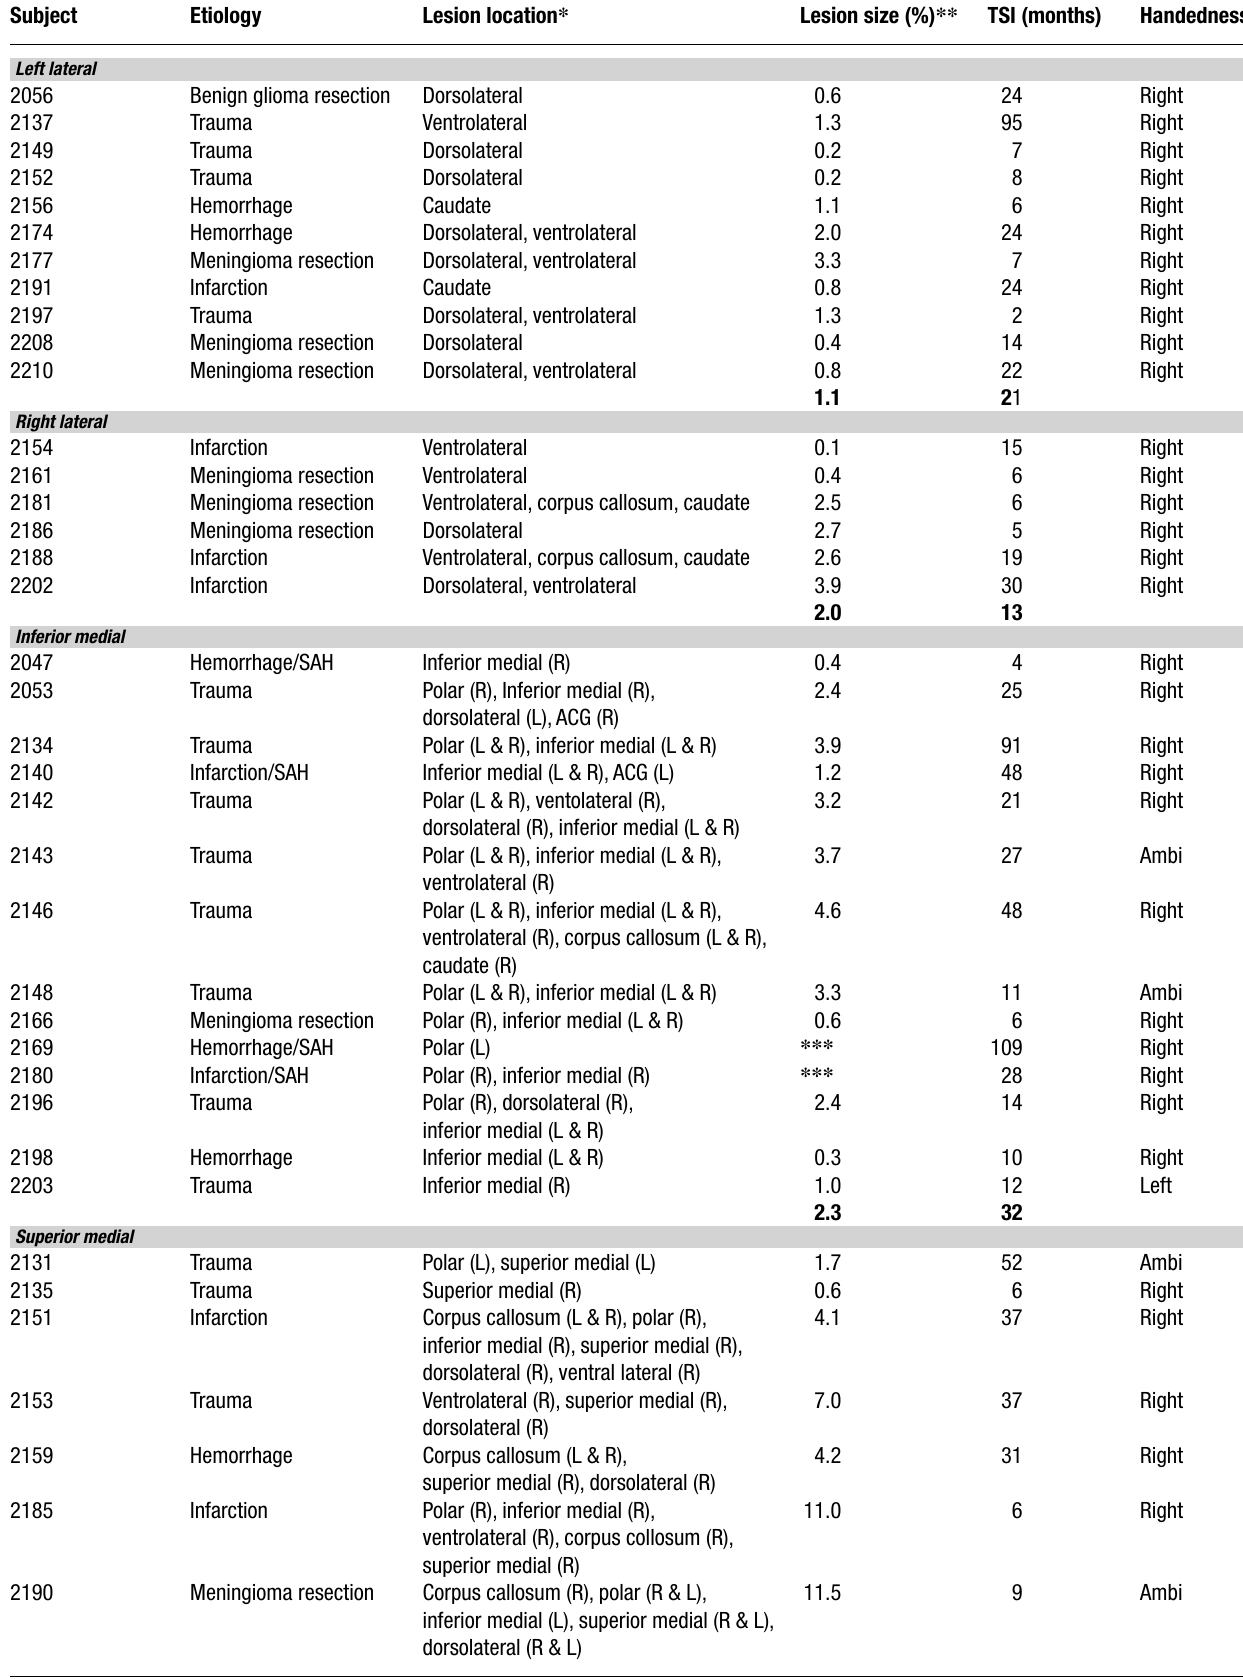
Table 1. Etiology, lesion location, lesion size, time since injury and handedness within patient